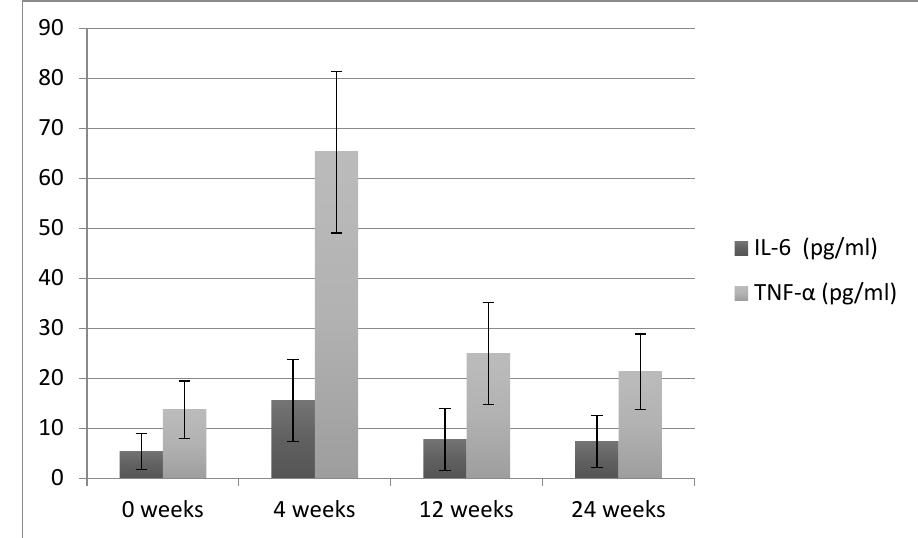
Figure 4. Comparison of IL-6 and TNF- α pg/mL as observed at baseline and different follow-up durations in patients treated with lumineers.